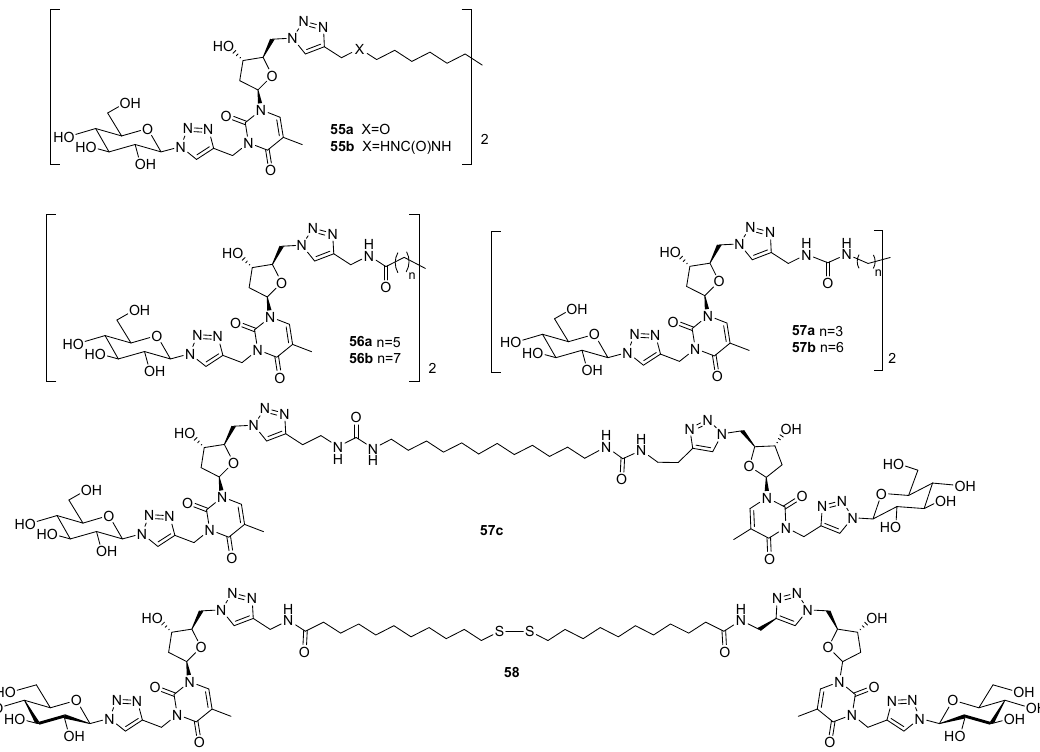
Figure 38. Structures of amide and urea containing bolaamphiphiles [84,85]